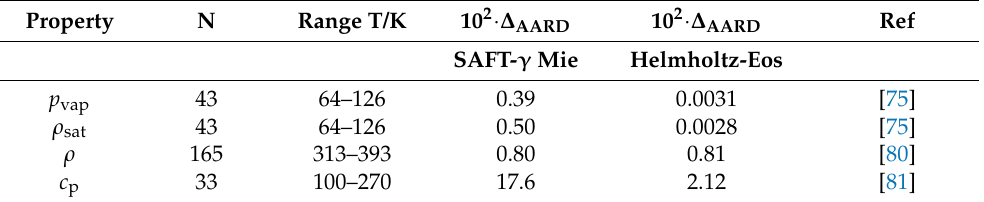
Table 12. Absolute average relative deviations ( ∆ AARD ) between experimental and calculated values obtained either with the SAFT- γ Mie approach or the Helmholtz energy equation of state (Helmholtz- EoS). p vap , ρ sat, ρ and c p are vapour pressure, saturated-liquid density, single-phase density and isobaric-specific heat capacity, respectively. N denotes the number of points.